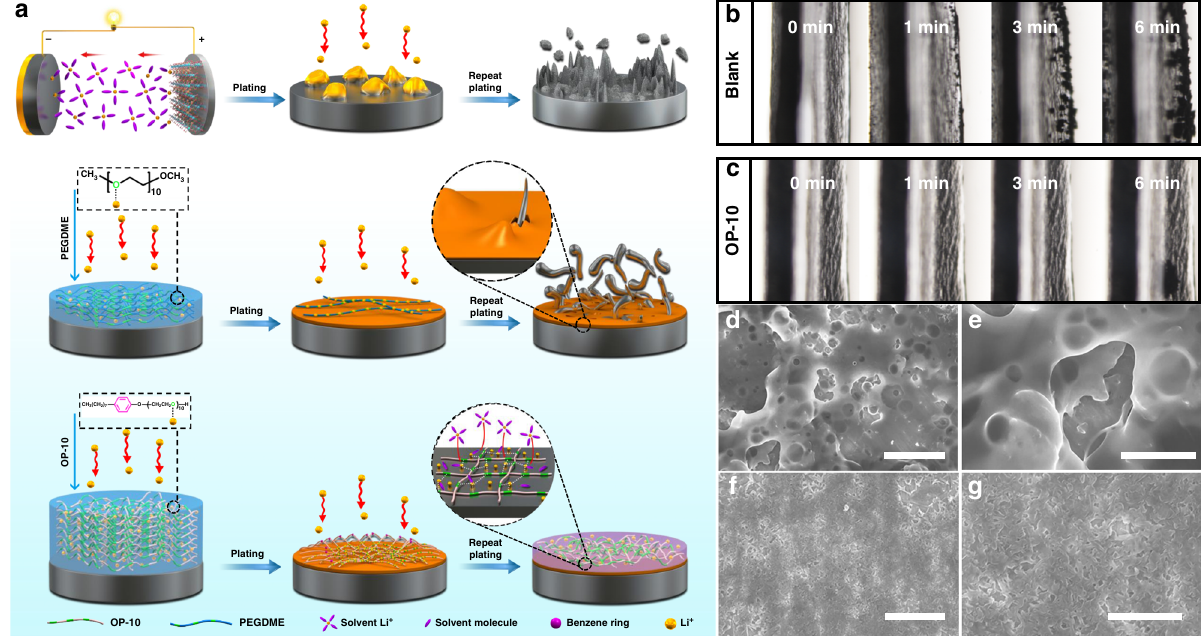
Fig. 1 Protection mechanism of OP-10 additive and morphology characterizations of Li deposition. Schematic illustration of lithium deposition with and without various additives ( a ). In situ optical microscopy images of the Li deposition process using electrolyte without additives ( b ) and electrolyte with 5% OP-10 additive ( c ) at a current density of 4 mA cm − 2 . The thickness of the Li is about 600 µ m. Top-view SEM images of lithium deposition on Cu foil at 0.5 mA cm − 2 for 0.4 h without ( d , e ) and with OP-10 additives ( f , g ) (Scale bars: d 20 μ m, e 10 μ m, f 20 μ m, g 10 μ m).